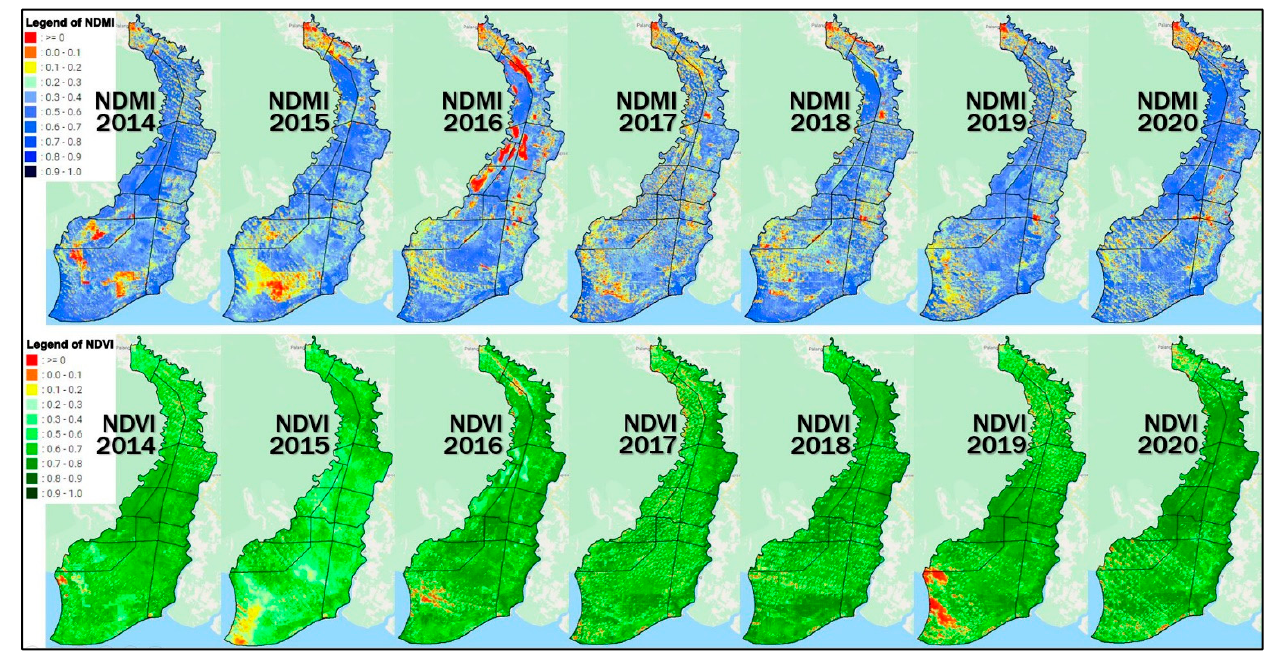
Figure 8. Calculation results and spatial distribution of the NDMI ( top ) and NDVI ( bottom ) in Kahayan–Sebangau PHU for 2014–2020 using Landsat-8 satellite images. (source: Landsat-8 using Google Earth Engine; processed by the authors).